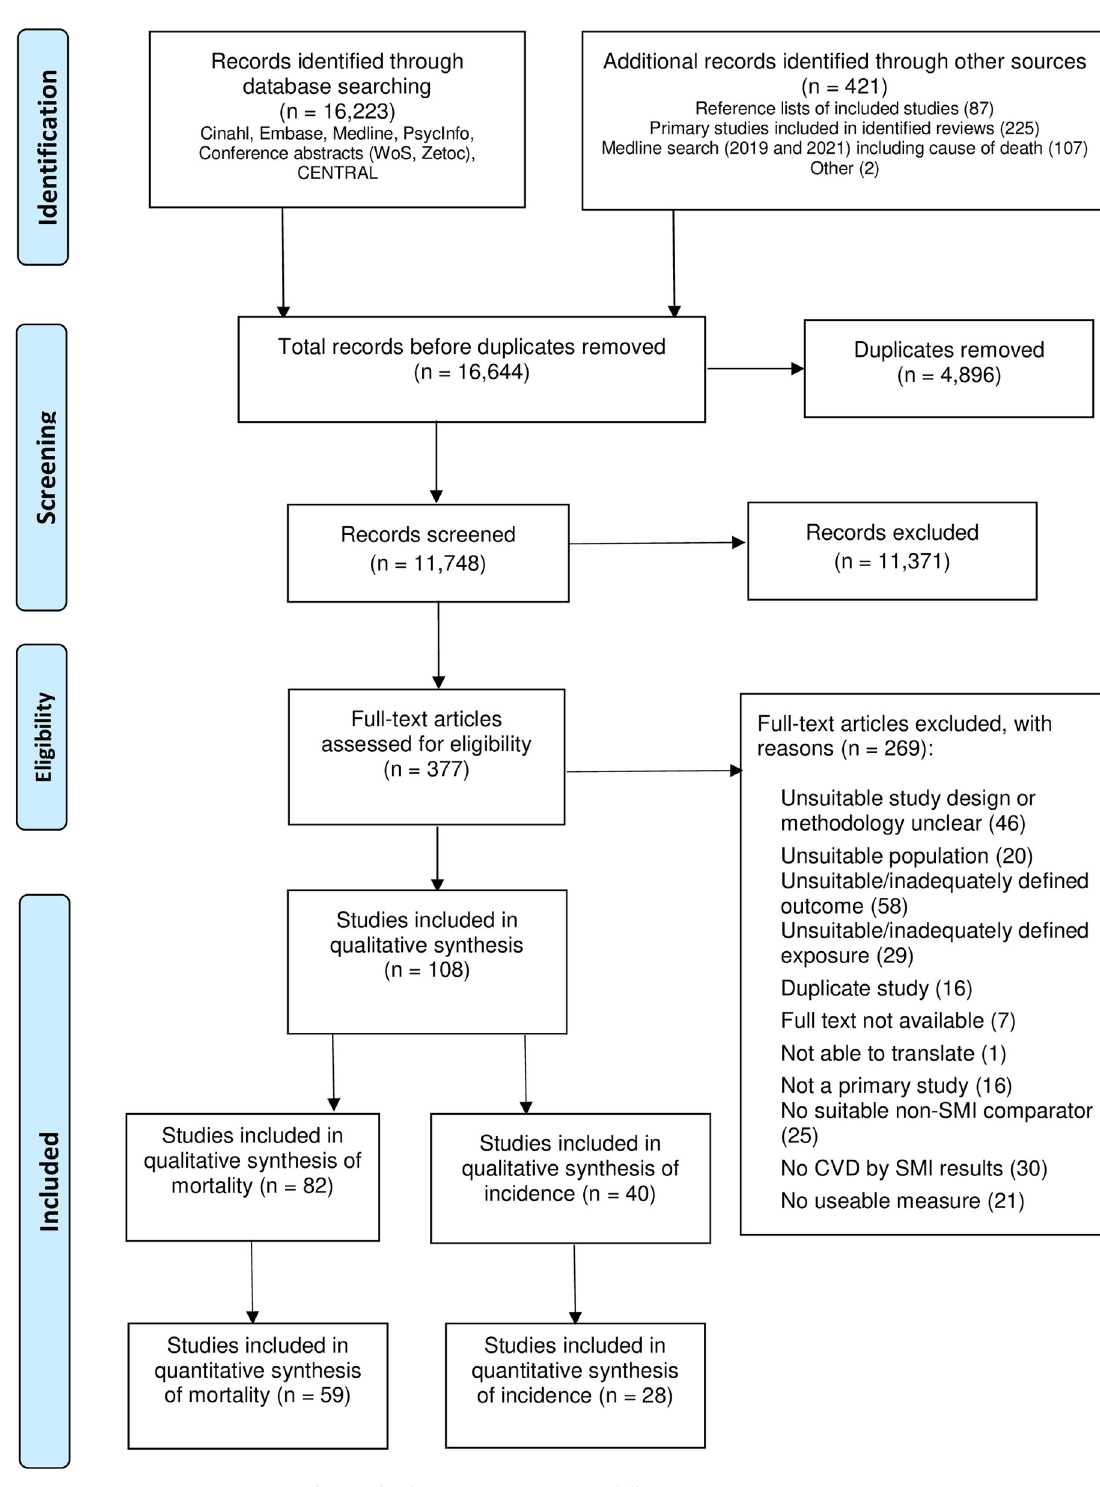
Fig 1. PRISMA flowchart. CVD, cardiovascular disease; SMI, severe mental illness.